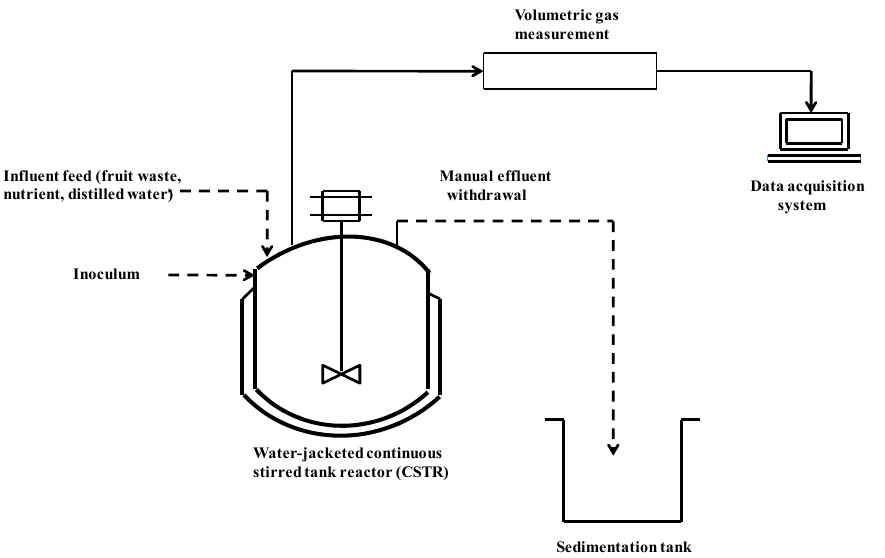
Figure 4. Schematic diagram of the fermentative hydrogen production from single and mixed